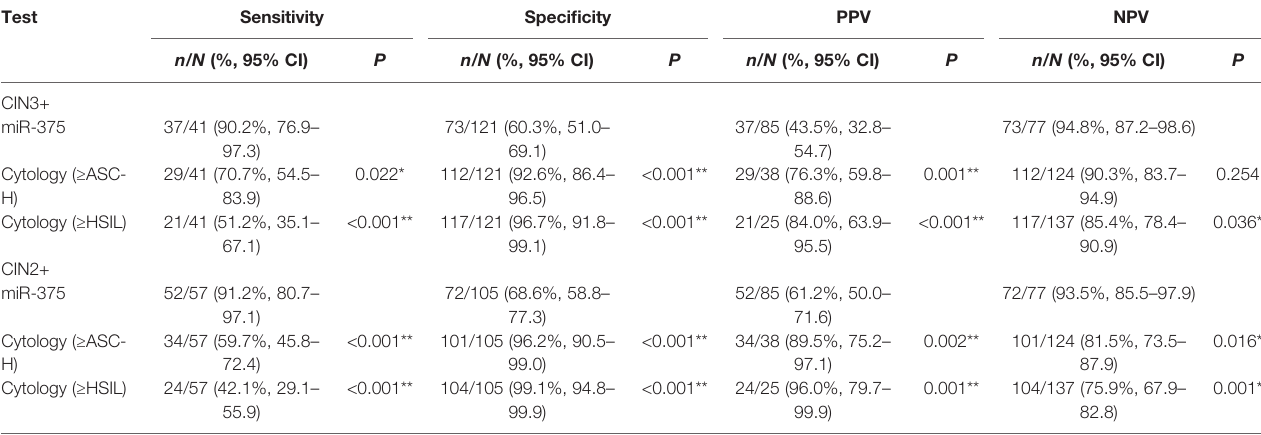
TABLE 3 | Comparison of performance ef fi ciency among miR-375 and cytology tests for detecting CIN3+ and CIN2+ in HPV16+ women.